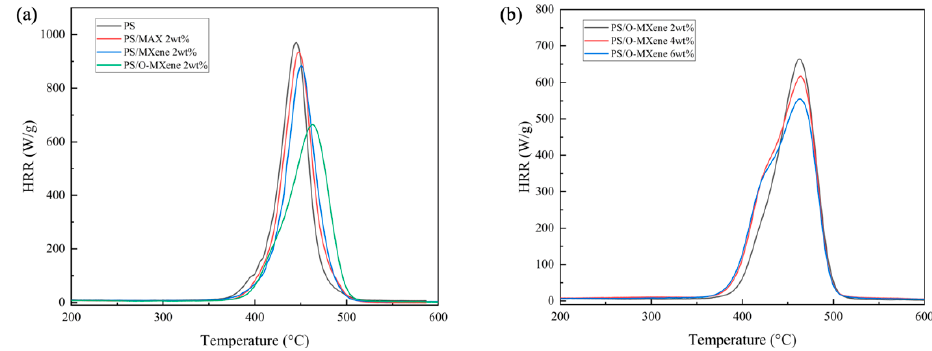
Figure 4. ( a ) PCFC HRR curves of PS and its nanocomposites with same weight ratio; ( b ) PCFC HRR curves of PS/O-Ti 3 C 2 nanocomposites with different weight ratios.